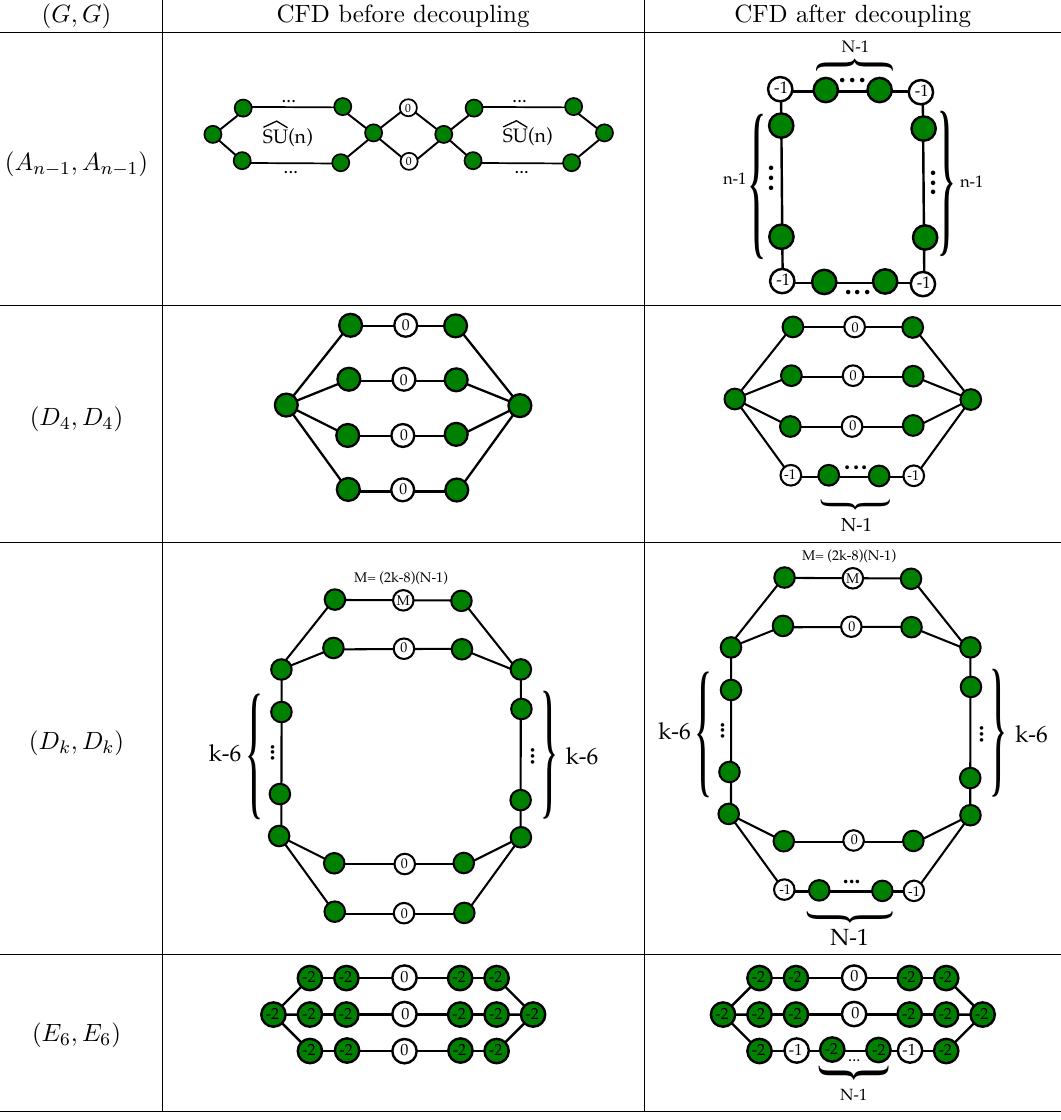
Table 5. CFDs for non-minimal N ( G; G ) conformal matter. The left hand picture shows the CFD before decoupling, the right hand one